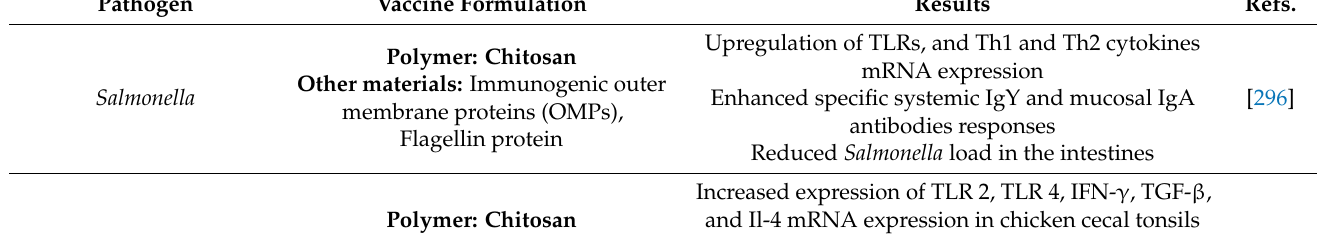
Table 3. Examples of antibacterial vaccines comprising polymers in their formulation. Pathogen Vaccine Formulation Results